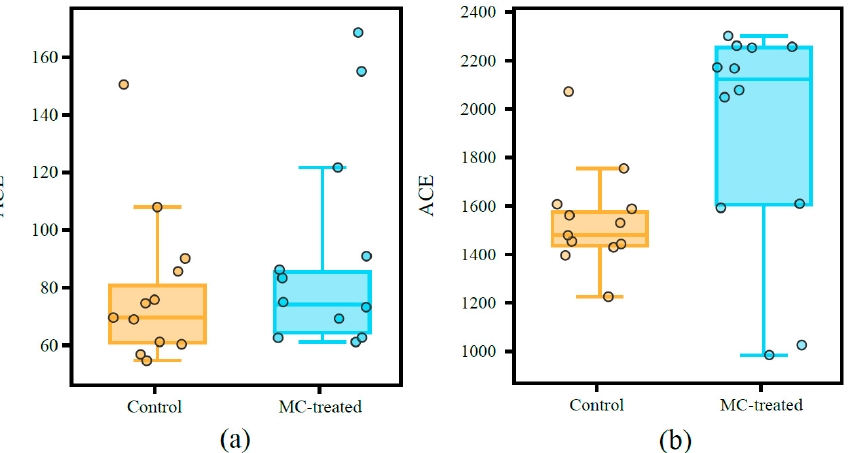
Figure 5. Alpha diversity of OTUs at different times in the control and MC-treated pond: ( a ) phytoplankton, Welch’s t -test, p value = 0.81; ( b ) bacteria, Welch’s t -test, p value = 0.03.